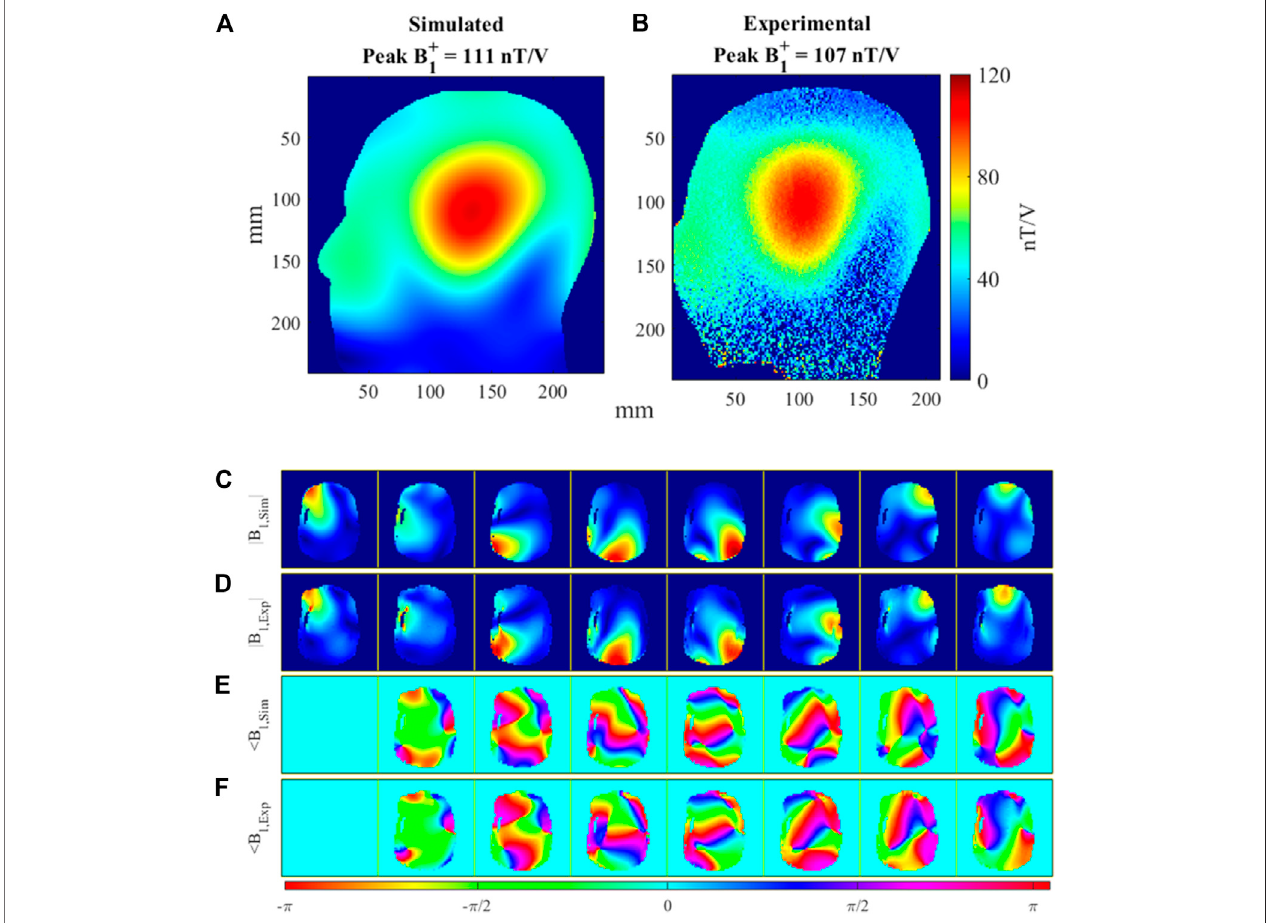
FIGURE 7 | Comparison of simulated and measured B 1+ maps in the head-and-shoulders phantom. (A) Simulated, sTx (CP mode) B 1+ map of Tx array and (B) matching experimental sTx B 1+ map. (C) Simulated, normalized |B 1+ | fi eld magnitude and (D) matching experimental, normalized |B 1+ | magnitude for all 8 Tx channels. (E) Simulated ∠ B 1+ fi eld phase and (F) matching experimental ∠ B 1+ phase for all 8 Tx